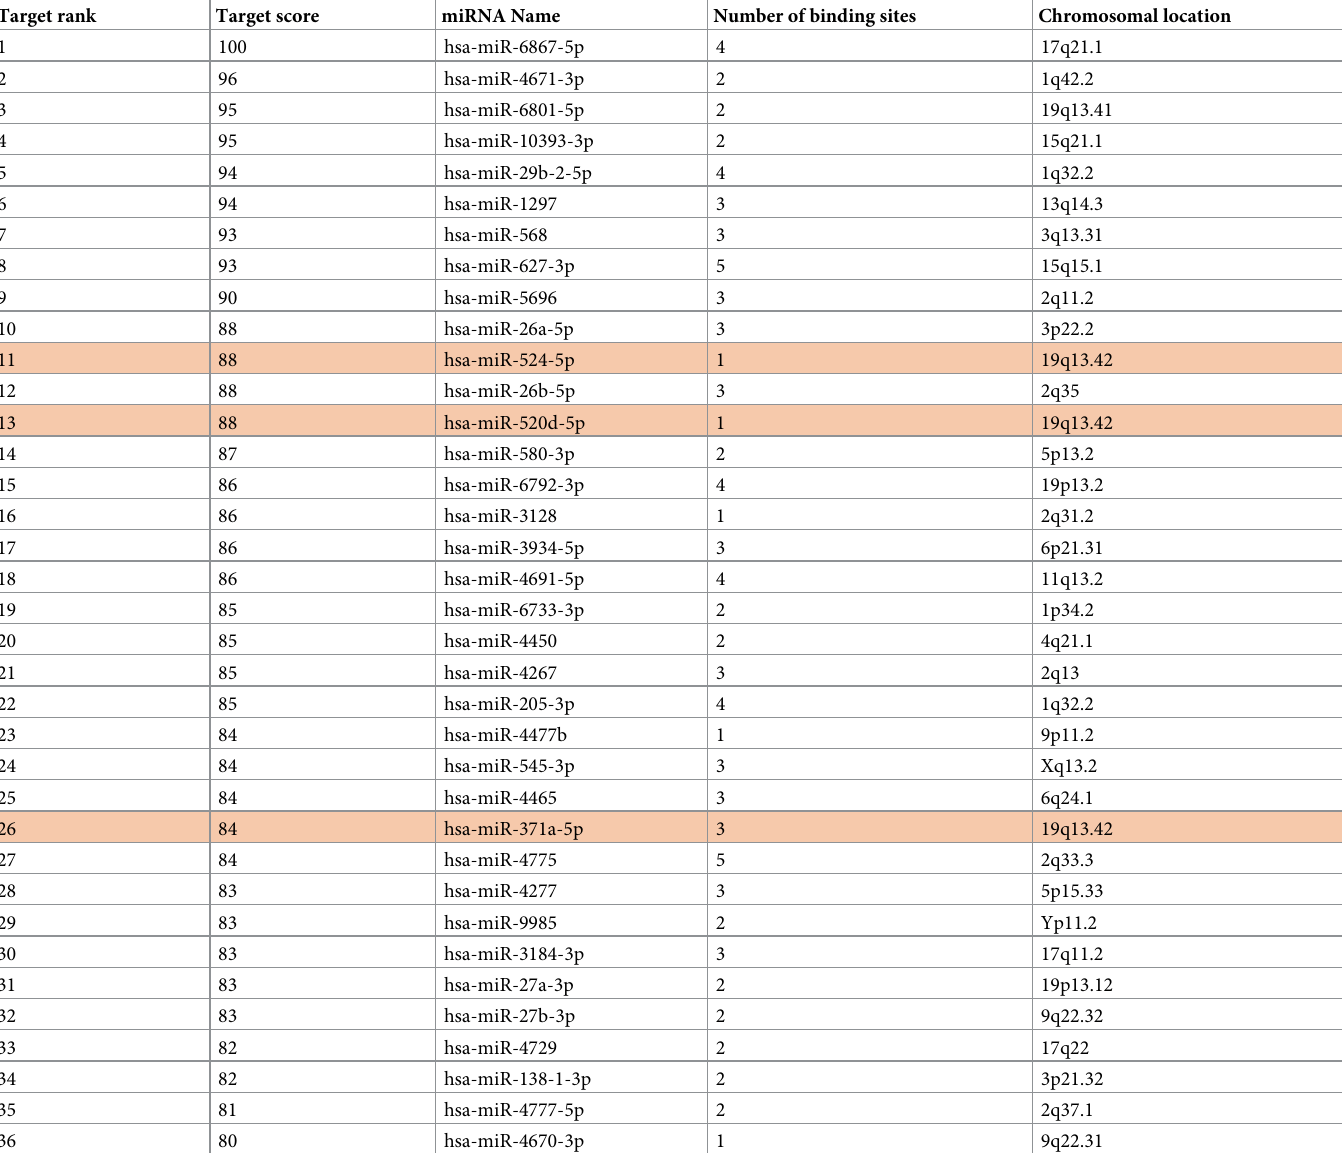
Table 6. Predicted miRNA binding sites in the 3 0 UTR of CPPED1 mRNA. Putative miRNA binding sites in the 3 0 UTR of CPPED1 were analyzed with miRDB soft- ware [44,45].Predicted targets with a prediction score of at least 80 were considered real. MiRNAs highlighted in orange belong to the placental chromosome 19 miRNA cluster (C19MC) or miR-371-3 cluster. In this study, miRNAs belonging to these clusters were checked for binding to the 3 0 UTR of CPPED1 mRNA. Target